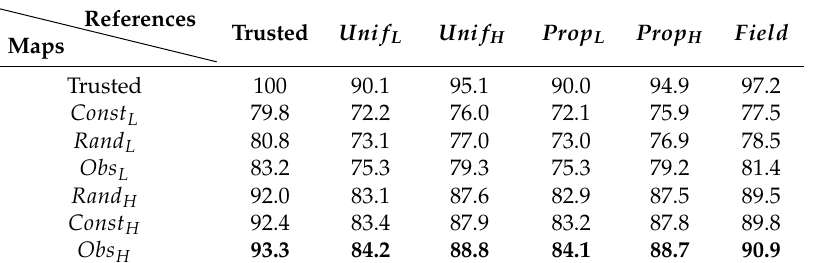
Table 1. Overall accuracies (OA) derived from the synthetic maps validated using reference datasets with conditionally independent errors. The first line refers to p ( j , k ) , the first column refers to p ( i , j ) and the other cells refer to p ( i , k ) . Maximum values for each type of reference dataset are in bold. The maps are sorted based on their OA with trusted reference. Const refers to constant errors on the off-diagonal cells, Rand refers to randomly selected errors, and Obs refers to errors rates that are based on a real case study. For the reference datasets, Unif correspond to uniformly distributed errors, Prop to errors rates proportional to the class frequency, and Field to errors observed in a real case study. The letters L and H refers to low and high quality, respectively.